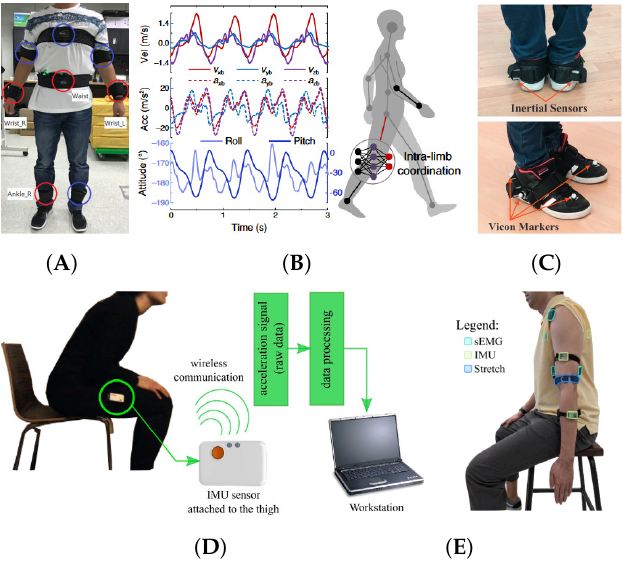
Figure 5. Examples of wearable systems that exploit the use of machine learning methods for activity recognition needed for assistive robots. ( A ) Multimodal sensor fusion with Long Short Term Memory networks for recognition of walking, sitting, lying, standing, driving and eating [103] (Licensed under (CC BY 4.0)). ( B ) Artificial Neural Networks for recognition of dynamic motion of human limbs [89] (Licensed under (CC BY 4.0)). ( C ) Gait detection using multimodal sensors with Hidden Markov Models and Artificial Neural Networks [82] (Reproduced with permission from Elsevier). ( D ) Detection of sit-to-stand and stand-to-sit using IMU sensors and Dynamic Bayesian Networks [81] (Reproduced with permission from Elsevier). ( E ) Prediction of elbow motion using multimodal sensors with Random Forest and Decision Trees [104] (Licensed under (CC BY